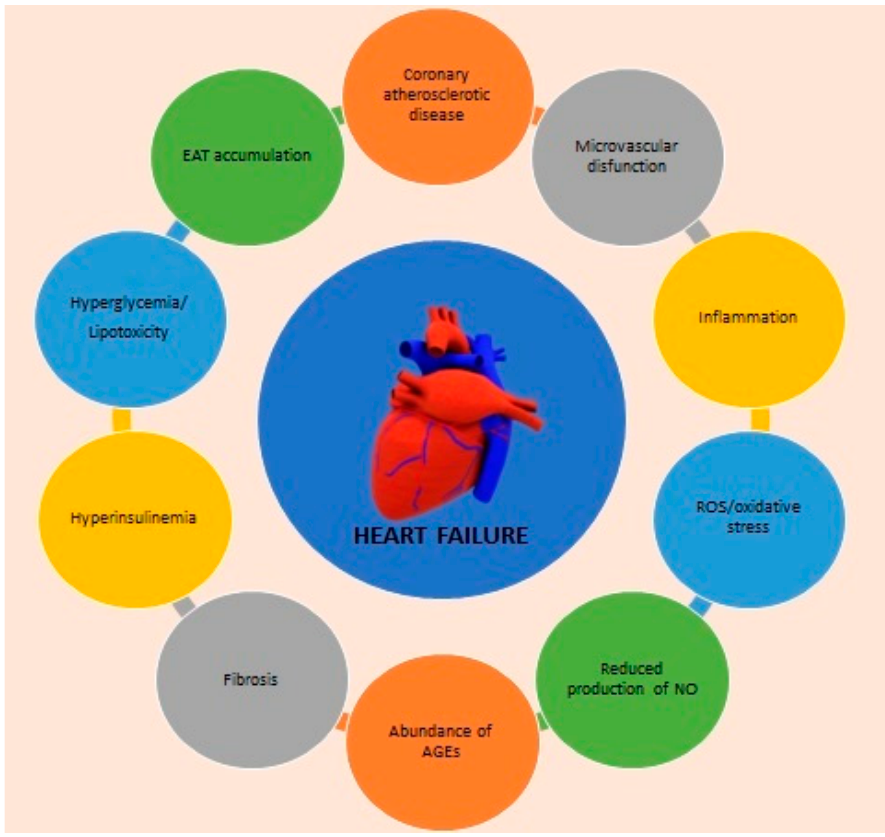
Figure 1. Multifactorial pathogenesis of heart failure in patients with T2DM. AGEs: advanced glycation end products, EAT: epicardial adipose tissue, NO: nitric oxide, ROS: reactive oxygen species.